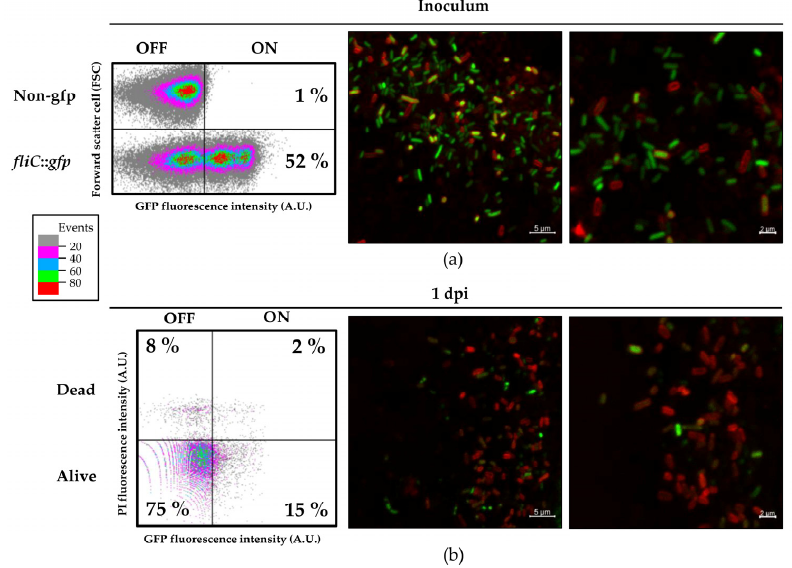
Figure 6. The fliC gene is heterogeneously expressed in plants. Dot plot representation of flow cytometry analysis of inoculum ( a ) and apoplast-extracted bacteria ( b ). Dot plots represent the GFP fluorescence intensity versus the forward scatter cell or the cell size, both in arbitrary units (A.U.) ( a ) or the GFP fluorescence intensity versus the propidium iodide (PI) fluorescence intensity, both in arbitrary units (A.U.) ( b ). The OFF subpopulation is defined as the fluorescence level below which 99% of the cells of a non-gfp strain cultured in the same conditions. Apoplast-extracted bacteria were stained with propidium iodide to determine percentage of dead cells. Representative CLSM image of bacterial cells within the inocula (upper panel) and apoplast-extracted bacteria (lower panel) from 1 dpi tomato leaves infiltrated with 5 × 10 8 CFU / mL. Red corresponds to membrane staining FM4–64. Scale bar corresponds to 5 µ m (left panel) and 2 µ m (right